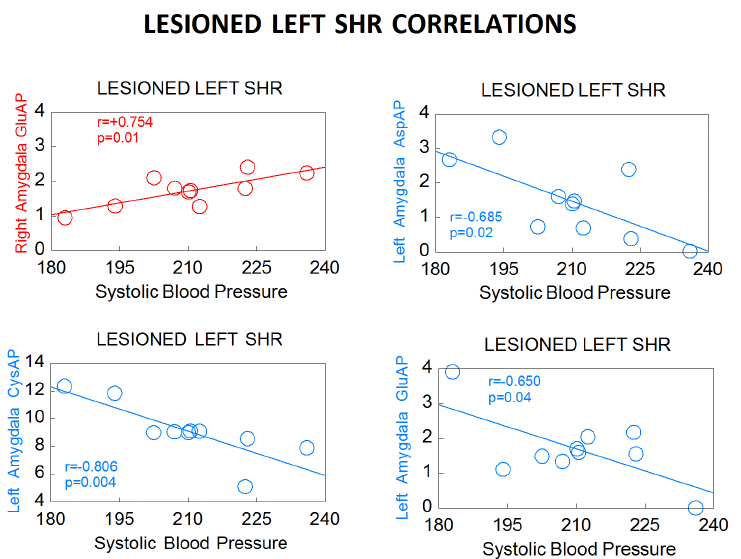
Figure 6. Significant correlations between aminopeptidase activities expressed as nmol of the corre- sponding L-amino acid- β -naphthylamide, hydrolyzed per min per mg of proteins in the left (blue) or right (red) amygdala and systolic blood pressure in lesioned left spontaneously hypertensive rats (SHR) (see Table 3). Negative correlations are in blue. Positive correlations are in red. Pearson’s correlation coefficients (r) and p values are indicated in each figure.